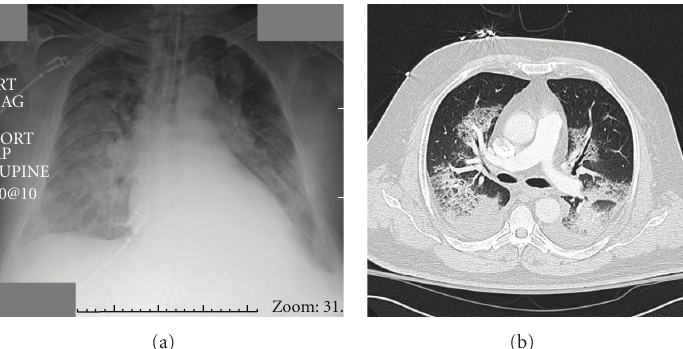
Figure 3: AP chest X-ray and accompanying select axial CT slice from the day of respiratory deterioration. The typical “ground glass” appearance and consolidation is